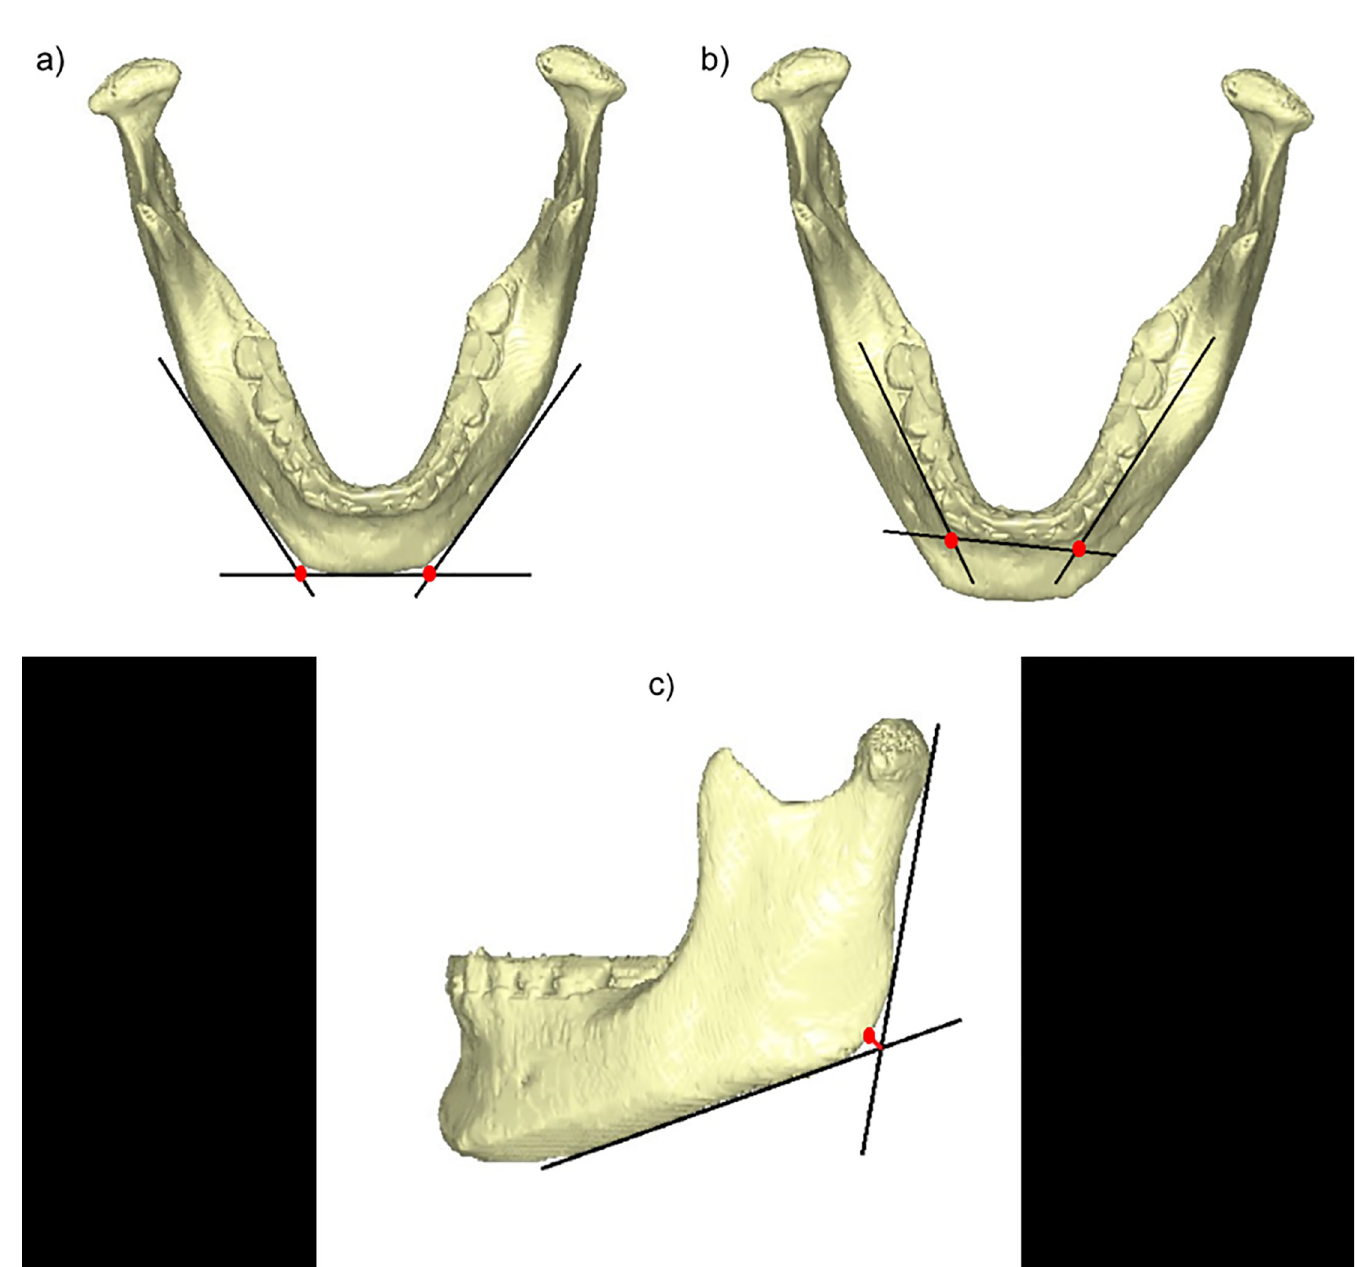
Fig 2. Simplified geometry of the mandible. a: the intersection of the tangents to the basilar edge of the symphysis and the basilar edge of the horizontal branch defines the position of the basilar inflexion reference point. b: the position of the “alveolar inflexion” reference point is defined by the intersection of the tangents to the alveolar vestibular borders of the incisor/canine and the molar regions. c: the gonial angle is defined as the angle between the tangent to the posterior border of the ramus and the tangent to the basilar edge of the mandibular body (horizontal branch). The gonion is the bony projection along the line that bisects the gonial angle.